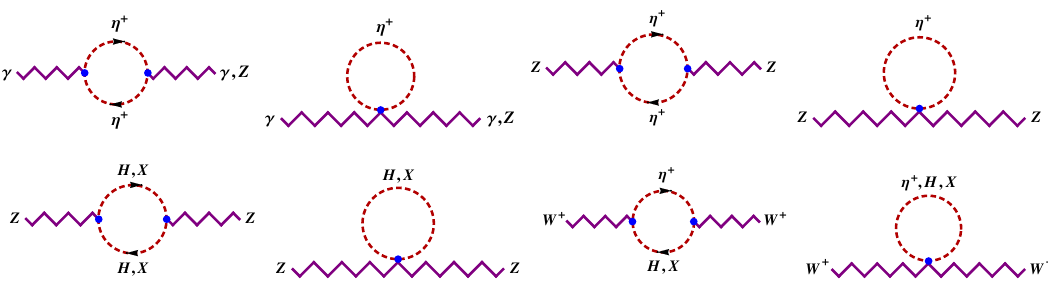
Figure 8 . Feynman diagrams for the contributions of the new scalars to the oblique parameters (cid:1) S ; (cid:1) T and (cid:1) U . two benchmark Yukawa couplings are given as